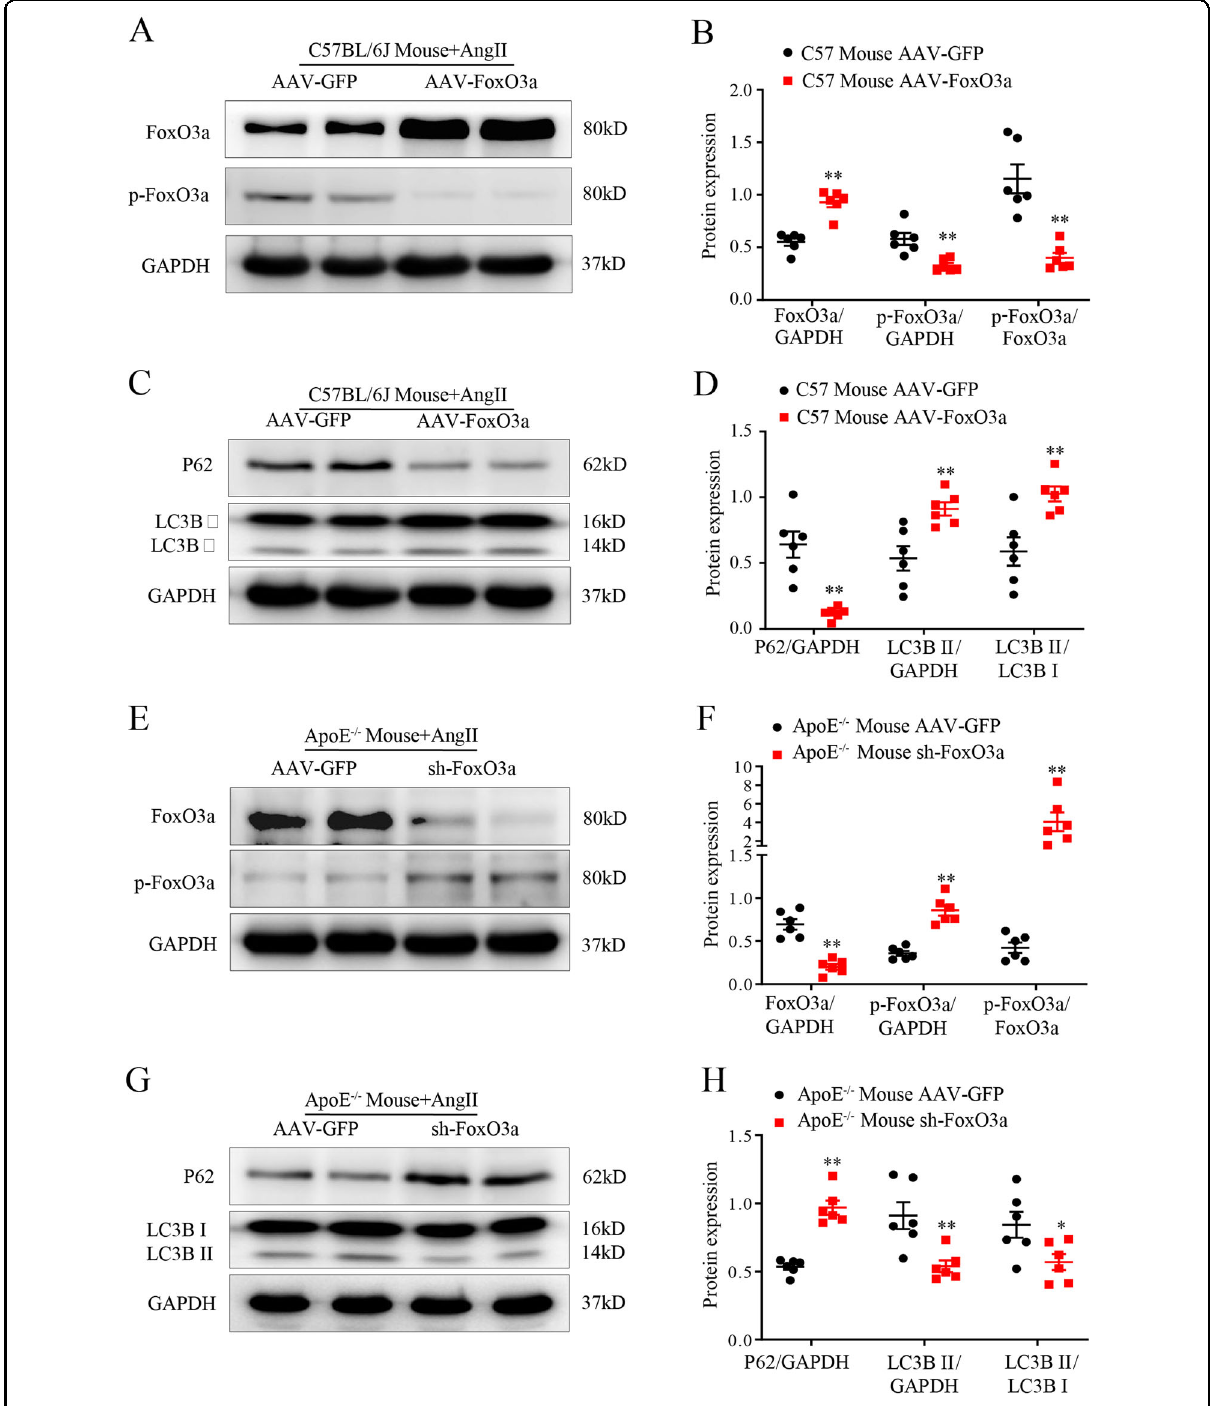
Fig. 7 FoxO3a promotes AAA formation by activating autophagy. A and B WBs and densitometric analysis of the protein levels of FoxO3a and p-FoxO3a in AAs from Ang II-infused C57BL/6J mice. Male C57BL/6J mice were treated with Ang II for 28 days, followed by transfection with AAV- FoxO3a or AAV-GFP ( n = 6). C and D WBs and densitometric analysis of the protein levels of P62 and LC3 β in AAs from Ang II-infused C57BL/6J mice. Male C57BL/6J mice were treated with Ang II for 28 days, followed by transfection with AAV- FoxO3a or AAV-GFP ( n = 6). E and F WBs and densitometric analysis of the protein levels of FoxO3a and p-FoxO3a in AAs from Ang II-infused ApoE − / − mice. Male ApoE − / − mice were treated with Ang II for 28 days, followed by transfection with AAV-GFP or sh-FoxO3a ( n = 6). G and H WBs and densitometric analysis of the protein levels of P62 and LC3 β in AAs from Ang II-infused ApoE − / − mice. Male ApoE − / − mice were treated with Ang II for 28 days, followed by transfection with AAV-GFP or sh-FoxO3a ( n = 6). Data are presented as the mean ± SE. * p < 0.05, ** p <